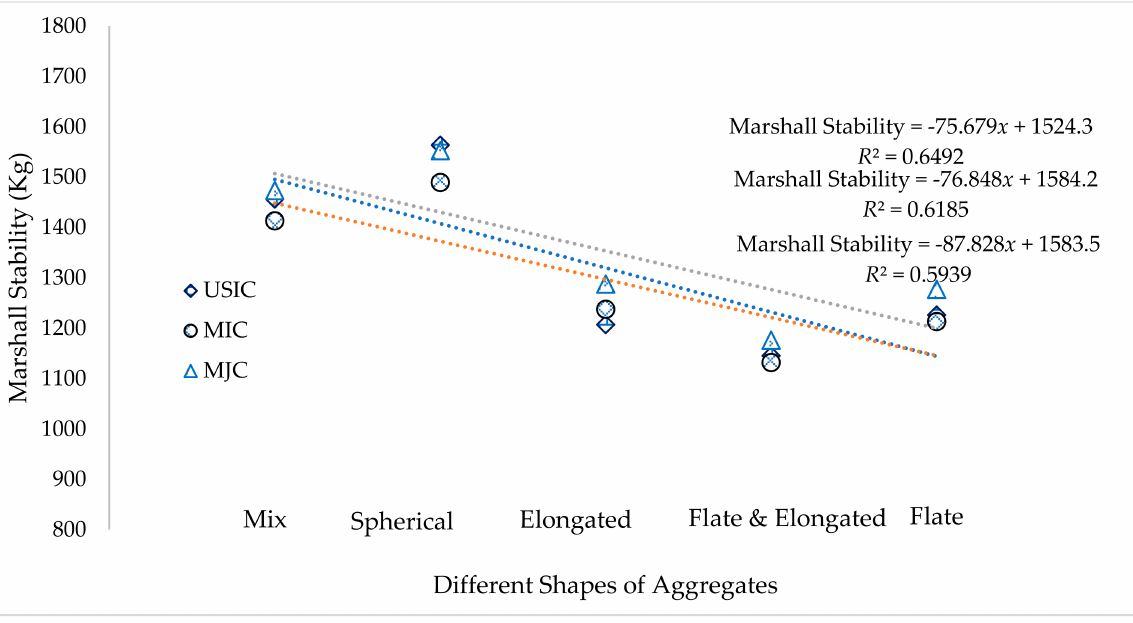
Figure 13. Correlation of Marshall stability with aggregate shape and crusher